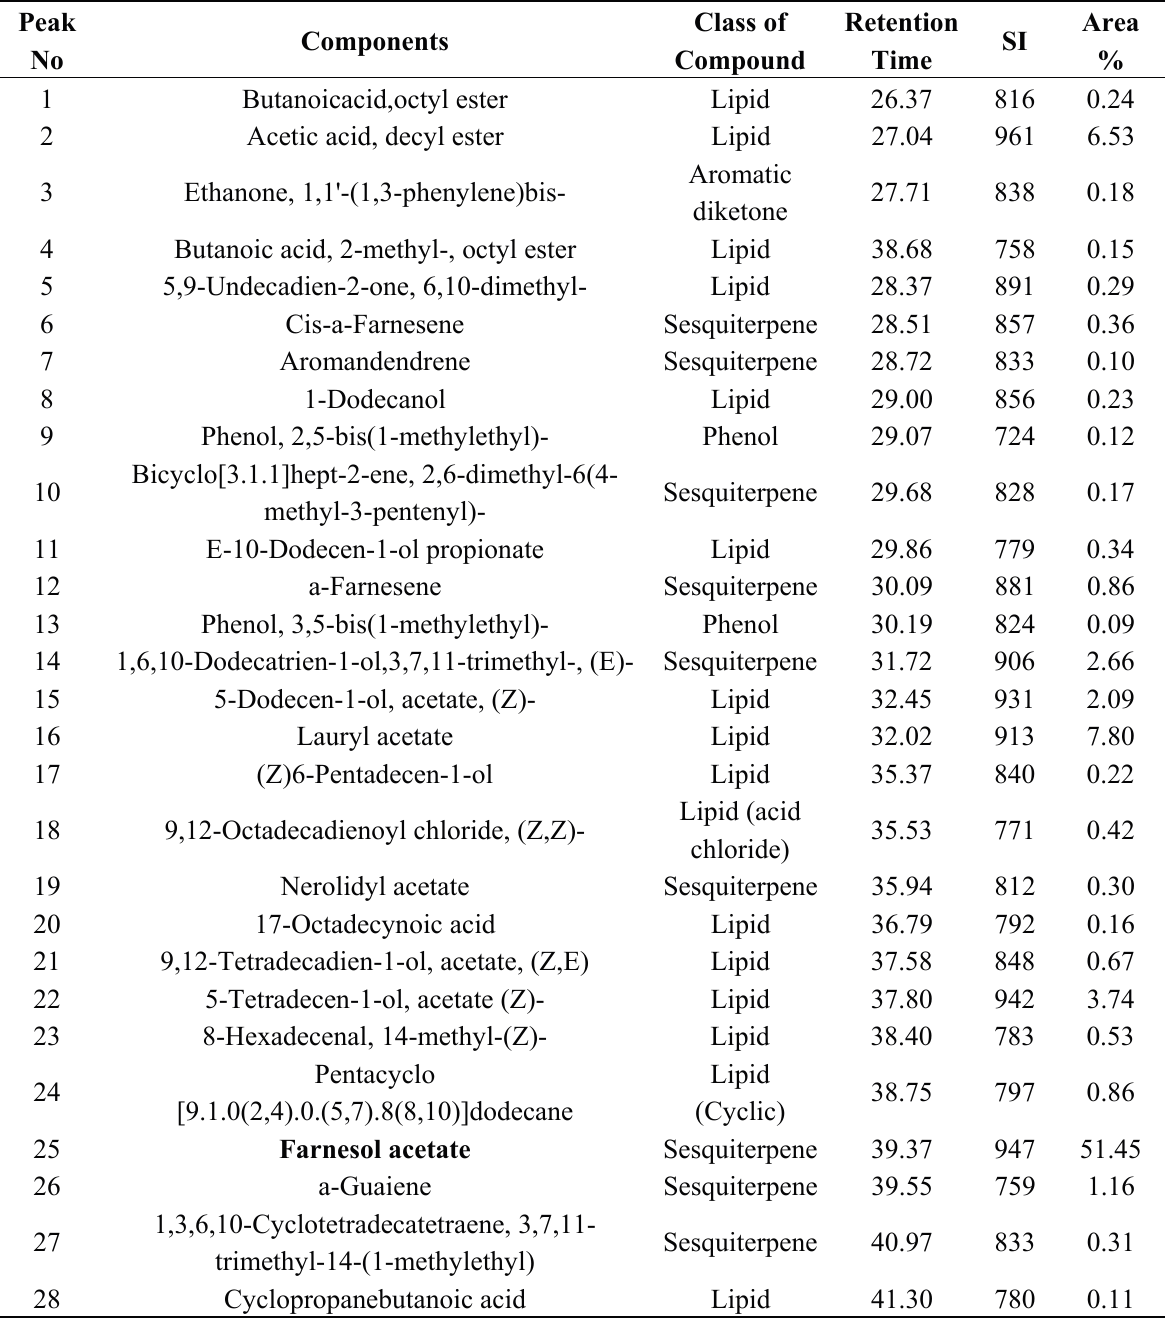
Table 1. Chemical composition of ambrette seed